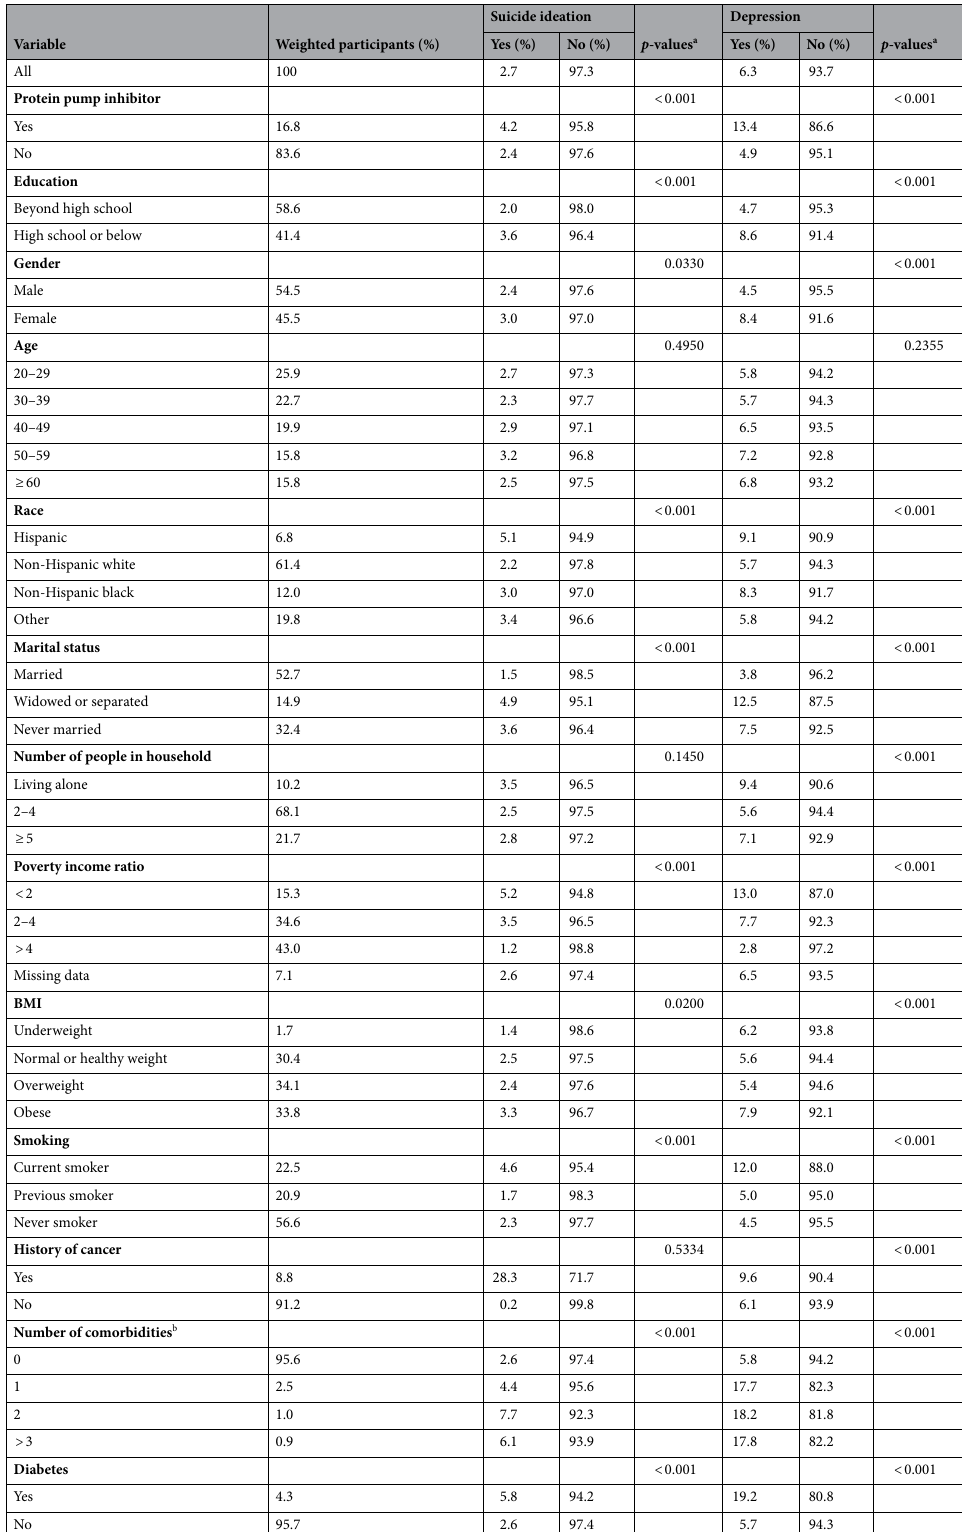
Table 1. Weighted characteristics of 16,881 participants by suicidal ideation and depression, NHANES 2005–2018. a Rao–Scott χ 2 statistics. b Comorbidities included angina, coronary heart disease, heart failure, myocardial infarction and